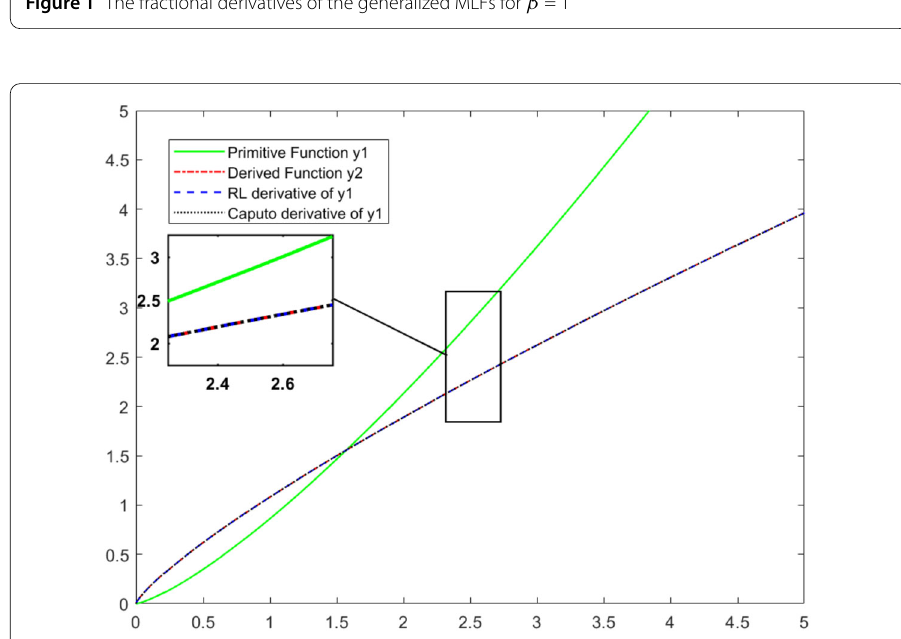
Figure 2 The fractional derivatives of the generalized MLFs for β (cid:5) = 1